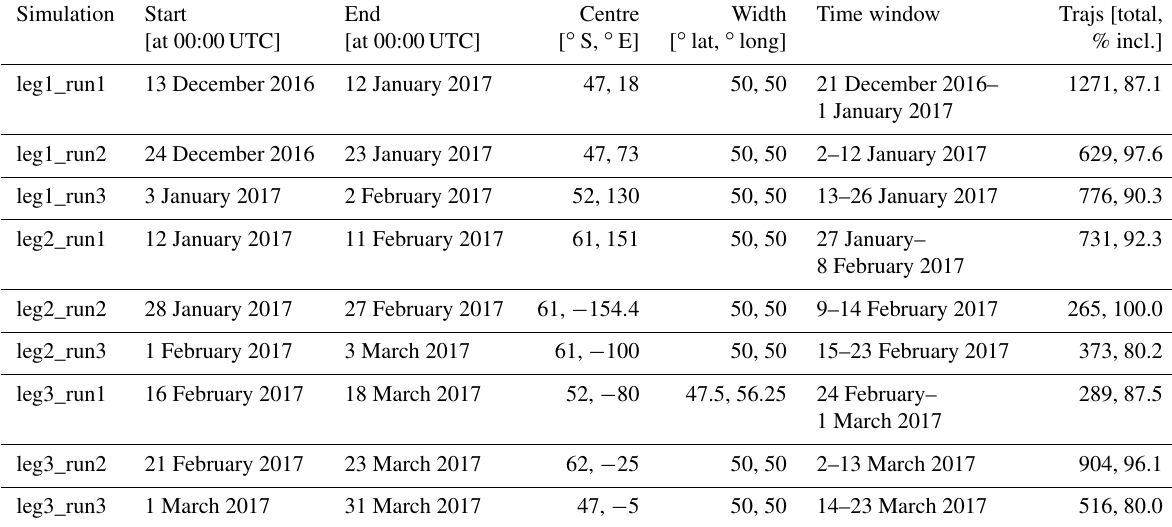
Table 1. Specifications of COSMO iso model simulations. The columns “Centre” and “Width” refer to the centre and width of the simulation domain. The column “Time window” shows the time period over which trajectories were calculated for the respective simulation. In column “Trajs”, the total number of trajectories arriving during cold and warm temperature advection (total) and the percentage of these trajectories included in the analysis based on the explained moisture fraction threshold (% incl.) are shown for each model simulation.